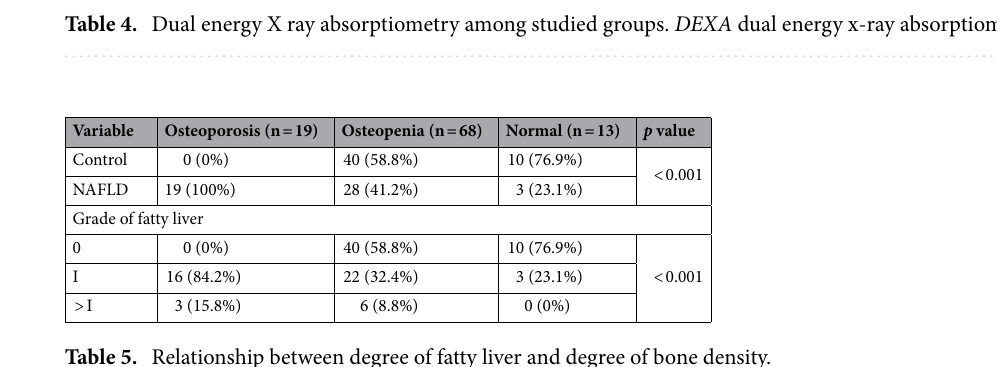
Table 5. Relationship between degree of fatty liver and degree of bone density.